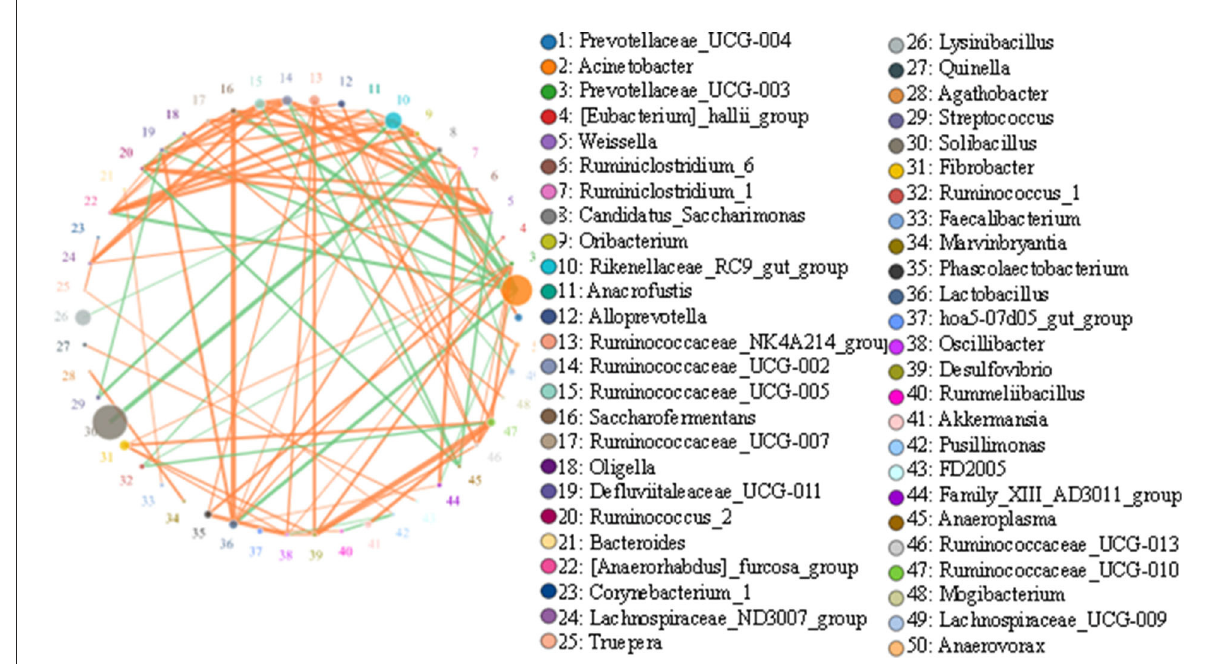
FIGURE7 Network diagram of each species at the genus level. Circles represent the species, and circle sizes represent the species’ average abundance size. Lines represent the correlation between the two species, and the thickness of the lines represents the strength of the correlation. Orange lines represent a positive correlation, and green lines represent a negative